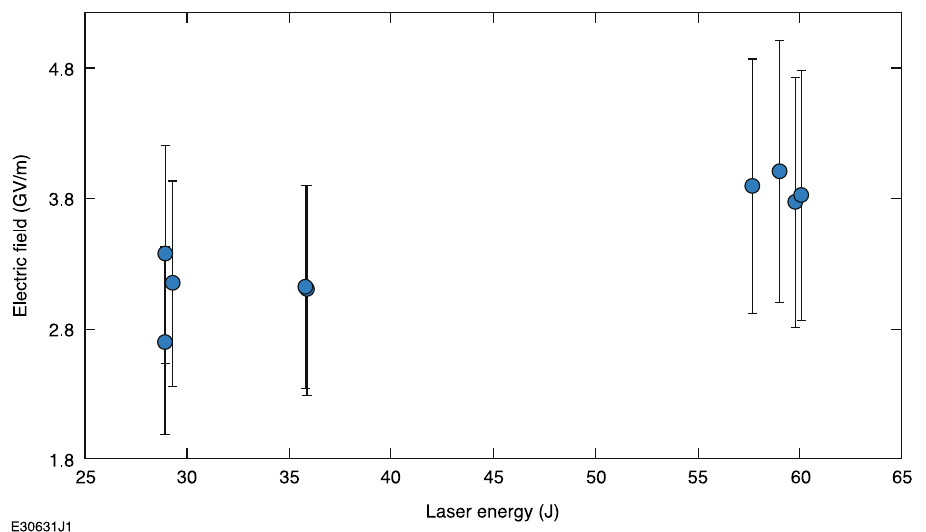
Figure 8. Estimated electric field to cause magnification change versus laser-drive energy used in the